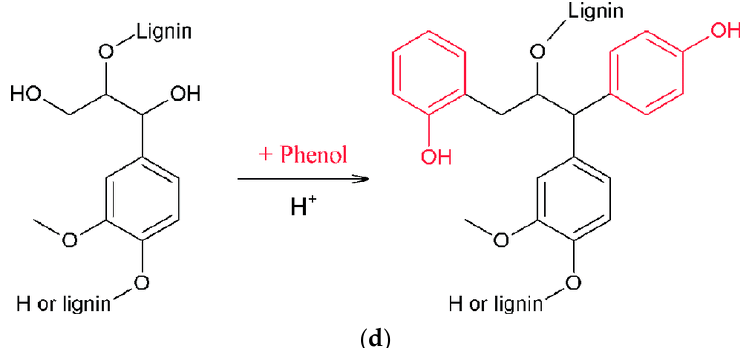
Figure 1. Schematic reactions between lignin and ( a ) glyoxal, ( b )ionic liquid, ( c ) maleic anhydride, and ( d ) phenolation.